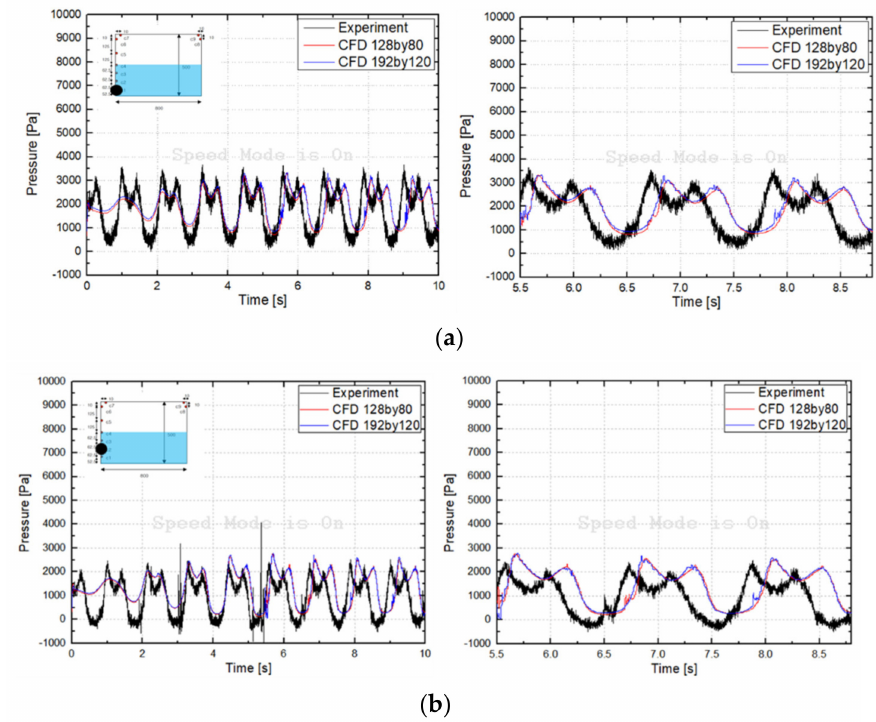
Figure 7. Comparison of hydro pressure history under the free water surface between experiment and CFD analysis at C1 sensor ( a ) and C2 sensor ( b